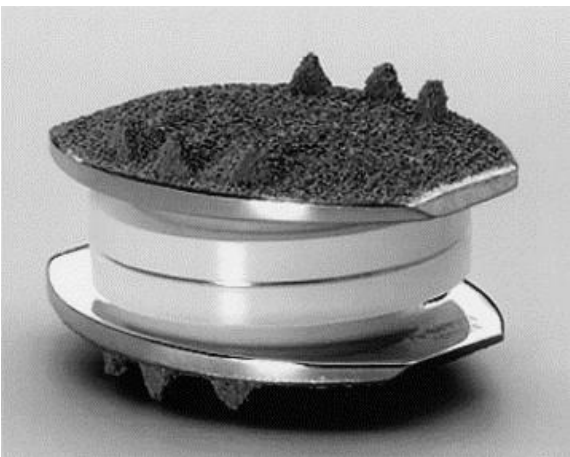
Figure 3. Charité III prosthesis (Depuy Spine, Rynam, MA, USA) composed of two cobalt chromium endplates with a UHMWPE sliding core. Reprinted/adapted with permission from Ref. [48]. 2005, Elsevier.